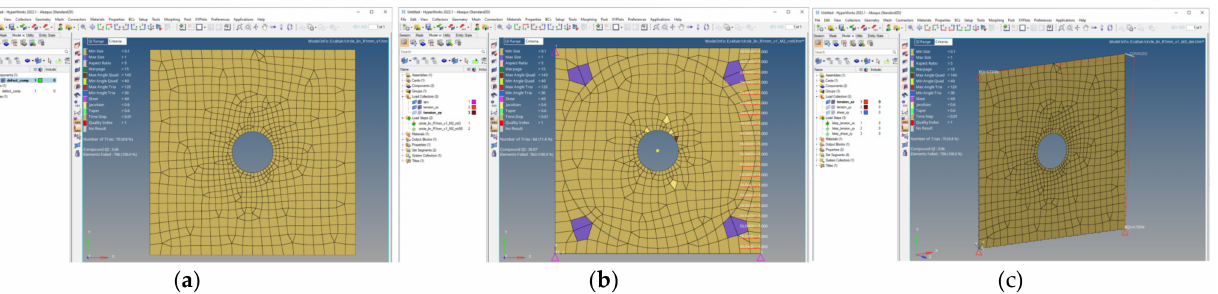
Figure 5. Setup of finite element models for both methods based on the same input mesh (circular hole-in-plate; referenced input mesh ‘circle_lin_R1mm_v1’): ( a ) Planar input mesh-pattern; ( b ) Re- meshed sub-case model with boundary conditions; and ( c ) Model of superposition method with boundary conditions and